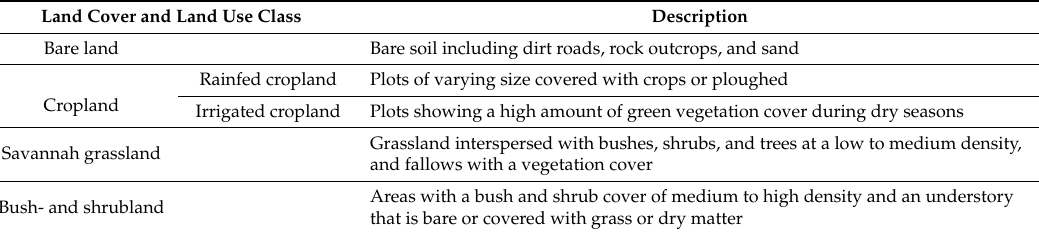
Table 1. Land cover and land use classes characterizing the landscapes in the study